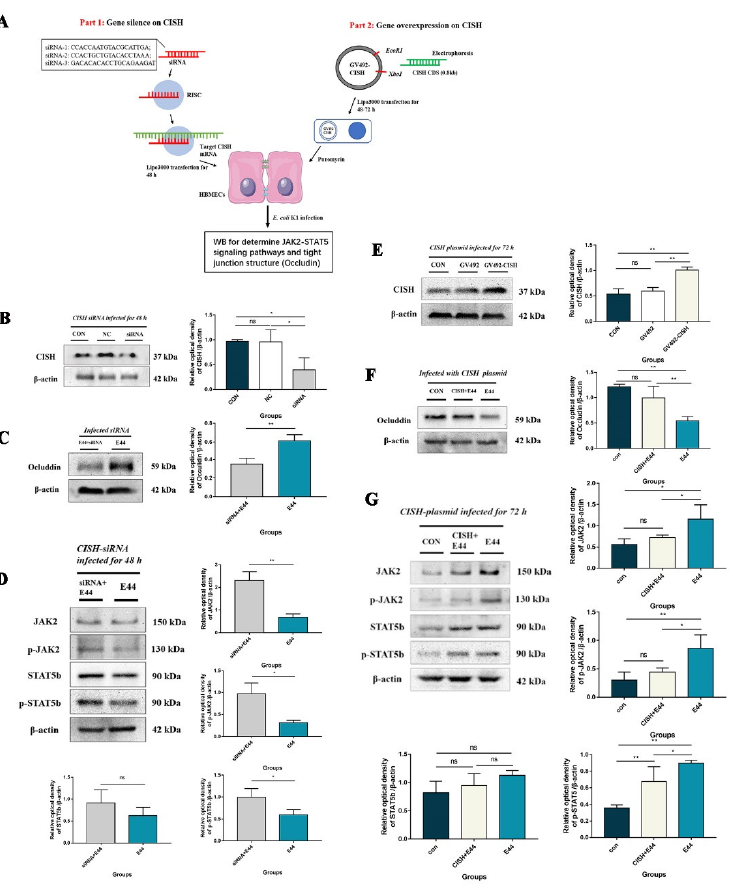
Figure 4. Gene silencing (siRNA) and over-expression (GV492) on the expression of CISH in HBMEC cells when infected with E. coli E44. ( A ) Experiment design in vitro. ( B ) The effect of siRNA-1, -2, and -3 on CISH expression in HBMECs, relative optical density analyzed by Image J. ( C ) The effect of siRNA on the tight junction protein (Occludin) in HBMECs treated with E. coli E44, relative optical density analyzed by Image J. ( D ) The expression of JAK2, p-JAK2, STAT5b and p-STAT5b in HBMEC cells (with/without) siRNA-1 when infected with E. coli E44, relative optical density analyzed by Image J. ( E ) The effect of GV492-CISH on CISH protein over-expressions in HBMEC cells. ( F ) The effect of GV492-CISH on the tight junction protein (Occludin) in HBMEC cells treated with E. coli E44. ( G ) The expression of JAK2, p-JAK2, STAT5b, and p-STAT5b in HBMEC cells (with/without) GV492-CISH when infected with E. coli E44, relative optical density analyzed by Image J. * p < 0.05, ** p < 0.01; NS, no significance.